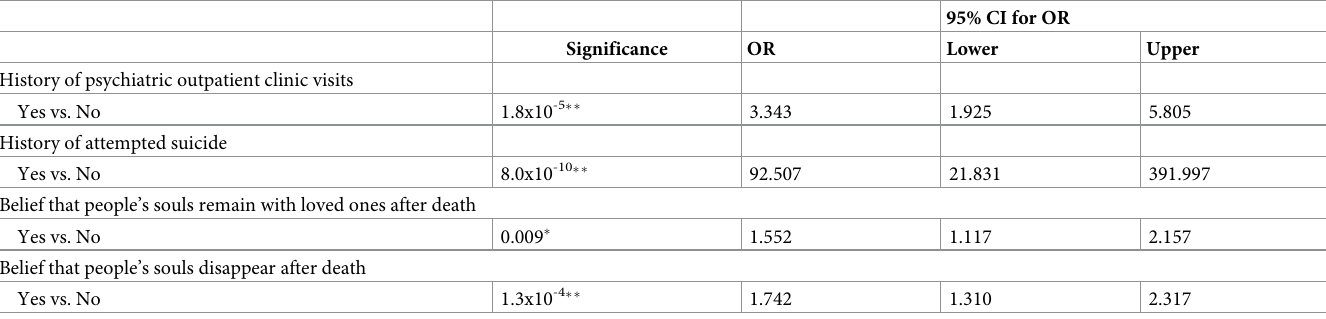
Table 3. Odds ratios and 95% confidence intervals for the risk of having suicide ideation (N =